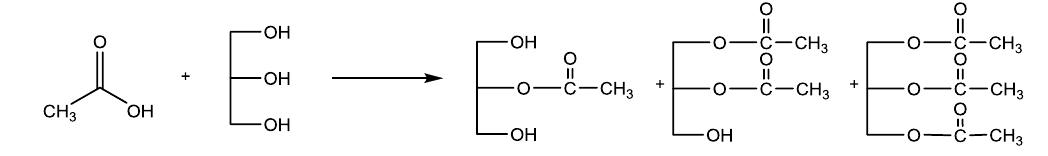
Figure 4. The esterification reaction: the acetylation of glycerol with the formation of glycerol monoacetate, glycerol diacetate and glycerol